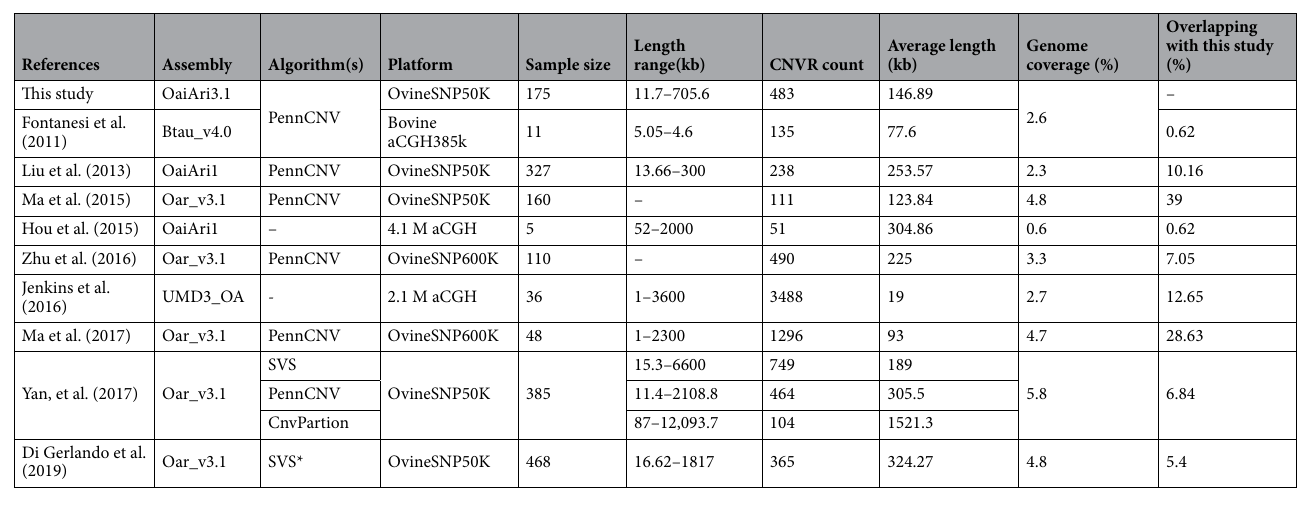
Table 5. Comparison of our study with recent ovine CNVR reports. *Golden Helix SNP and Variation Suite